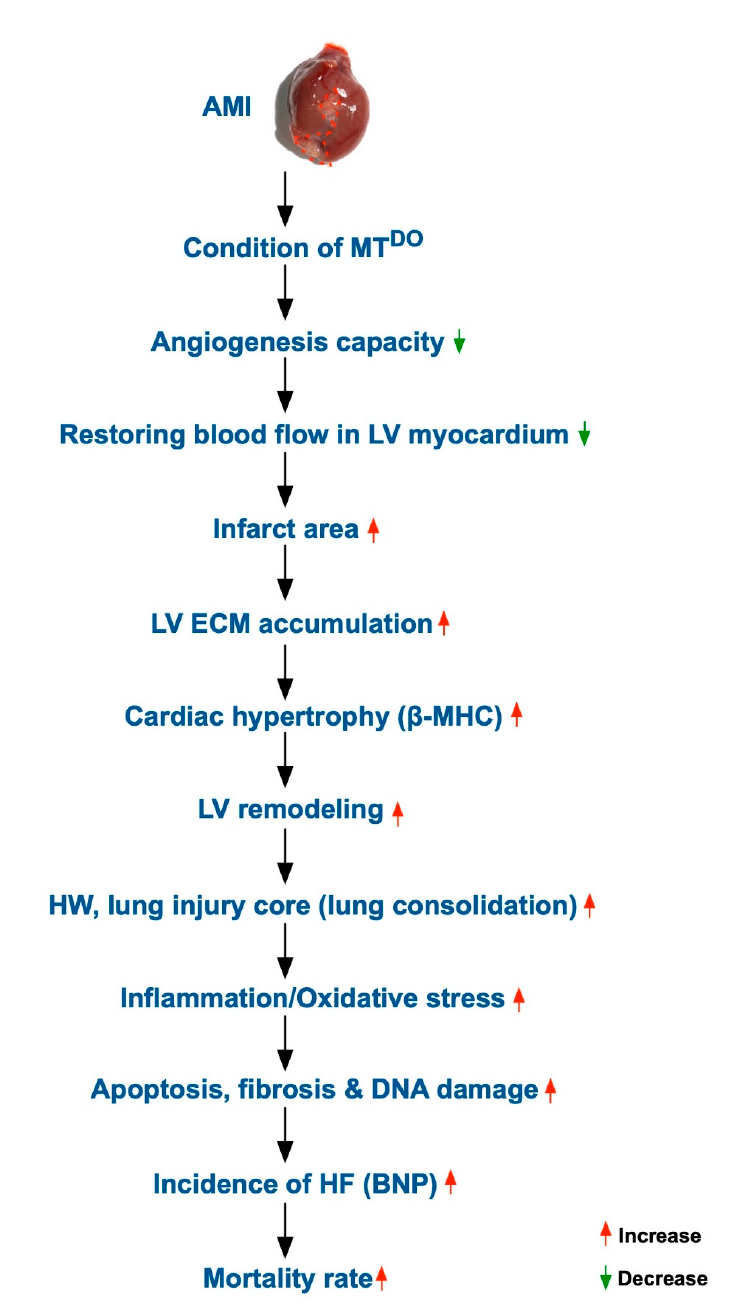
Figure 9. Schematic of the proposed mechanism of the e ff ect of tPA / MMP9 deficiency on the prognostic Figure 9 . Schematic of the proposed mechanism of the effect of tPA/MMP9 deficiency on the outcome in MT DKO mice after AMI prognostic outcome in MT DKO mice after AMI induction .